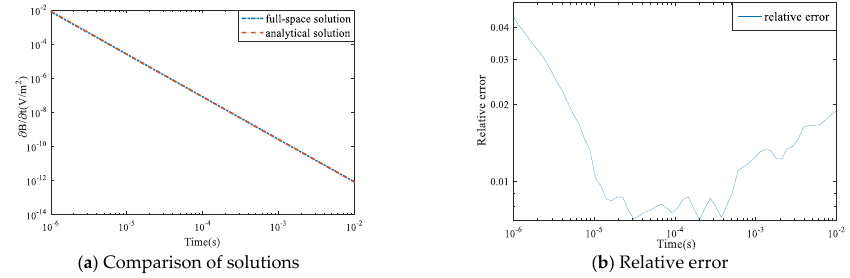
Figure 5. Comparison of numerical and analytical solutions.